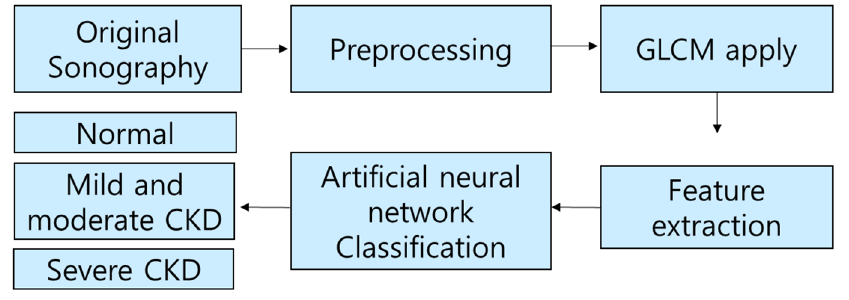
Figure 2. Total block diagram of image processing.